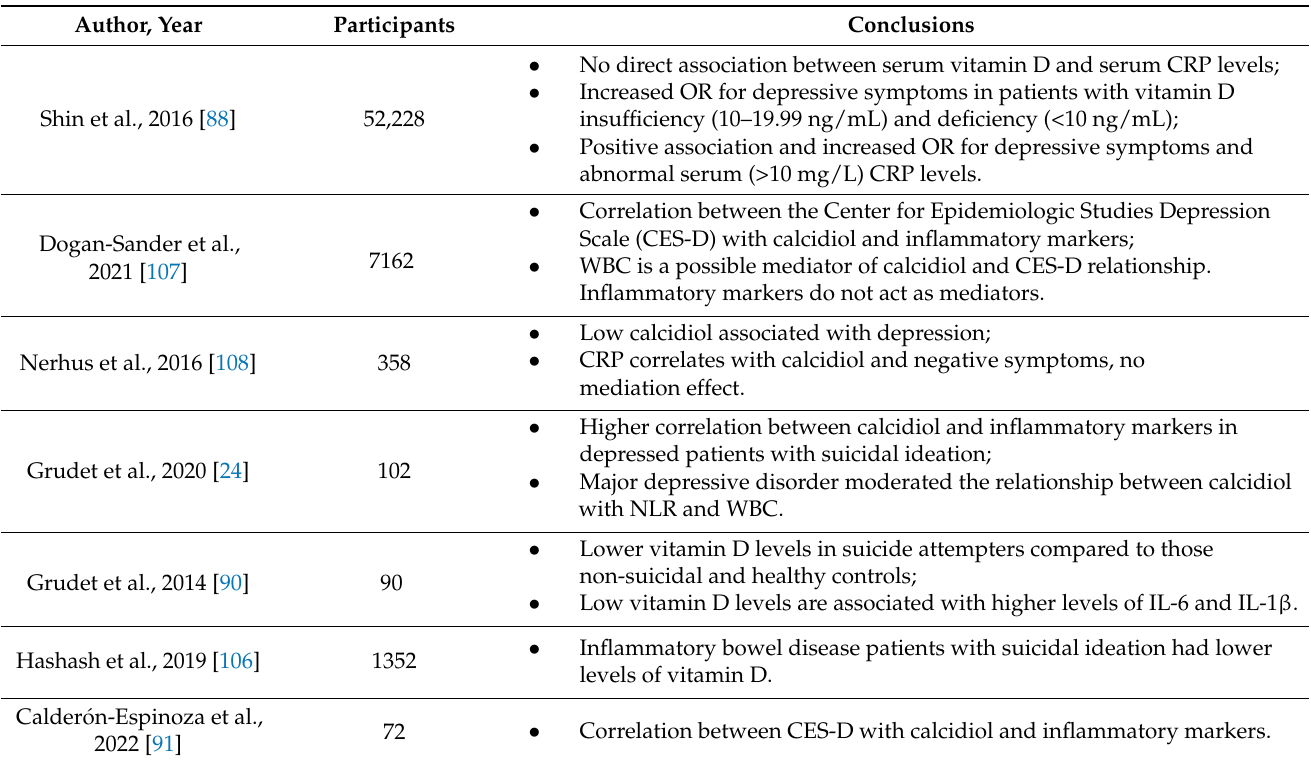
Table 3. Studies on the relationship between vitamin D, inflammation, and depressive